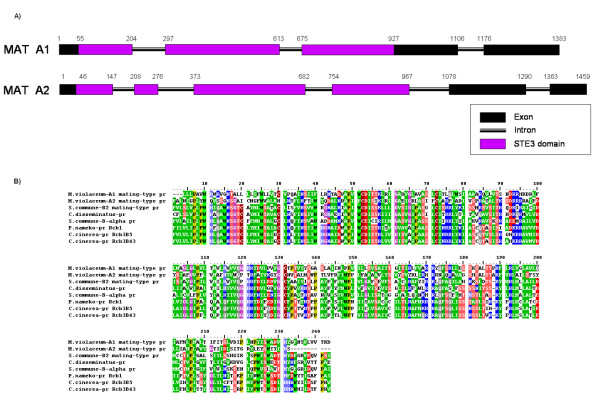
Putative pheromone receptors in Microbotryum. violaceum. A) Diagram of the two putative pheromone receptor genes identified in the EST library of Microbotryum violaceum, respectively linked to the A1 and A2 mating type. B) Alignment of the two putative pheromone receptors of Microbotryum violaceum with the most similar published protein sequences of other fungi: B2 and B-alpha of Schizophyllum commune, the transmembrane pheromone receptor of Coprinellus disseminatus and Rcb3B5 of Coprinopsis cinerea.